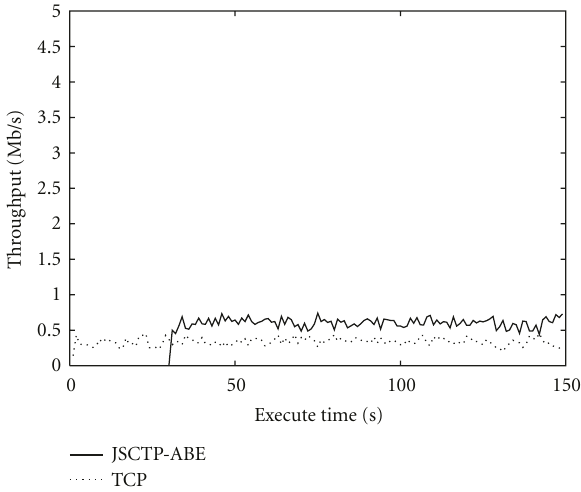
Figure 16: 5% loss rate of TCP friendliness with 5 Mb